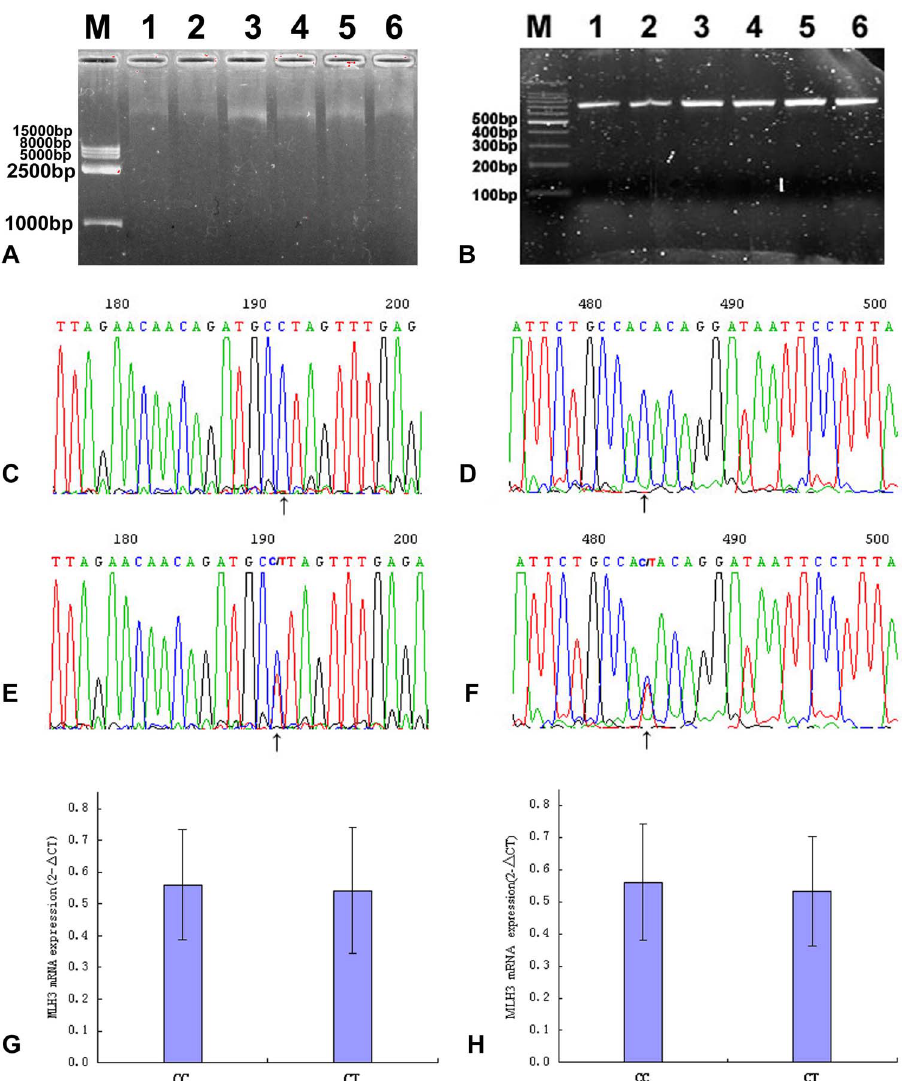
Figure 1. MLH3 Thr942Ile, Pro844Leu genotypes and MLH3 mRNA expression level detection. ( A ) Genomic DNA electrophoresis. M: Wide Range DNA Marker (500–15000); 1,2: Control; 3,4: CIN III; 5,6: CSCC. ( B ) Electrophoresis of PCR products. M: 100 bp DNA Ladder (Dye Plus); 1,2: Control; 3,4: CIN III; 5,6: CSCC. ( C,E ) Sequencing histogram of MLH3 Pro844Leu genotype. ( D,F ) Sequencing histogram of MLH3 Thr942Ile genotype. ( G ) Correlation of Pro844Leu genotypes with MLH3 mRNA expression levels. Mean values for Pro844Leu genotypes are: 0.561(CC), 0.543(CT). ( H ) Correlation of Thr942Ile genotypes with MLH3 mRNA expression levels. Mean values for Thr942Ile genotypes are: 0.561(CC), 0.533(CT).